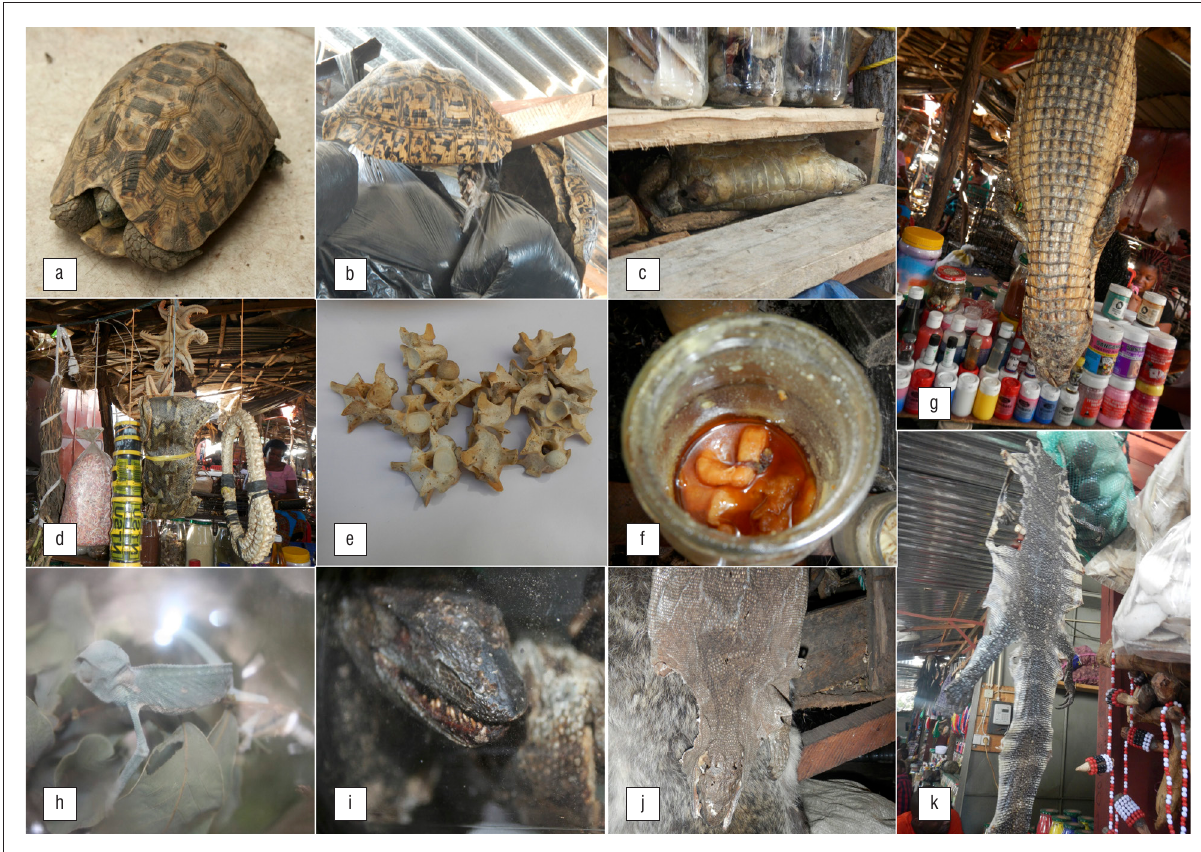
Figure 1: Reptiles recorded in the 2015/2016 Xipamanine and Xiquelene Market surveys. (a) Live Kinixys sp.; (b) Stigmochelys pardalis carapaces; (c) concealed Crocodylus niloticus skin; (d) Python natalensis skin and vertebrae (rolled up); (e) handful of Python natalensis vertebrae; (f) allegedly Python natalensis fat; (g) whole Broadleysaurus major ; (h) live Chamaeleo dilepis dilepis in a plastic bottle; (i) Varanus niloticus in a container; (j) whole Varanus niloticus skin; (k) whole Varanus albigularis skin.